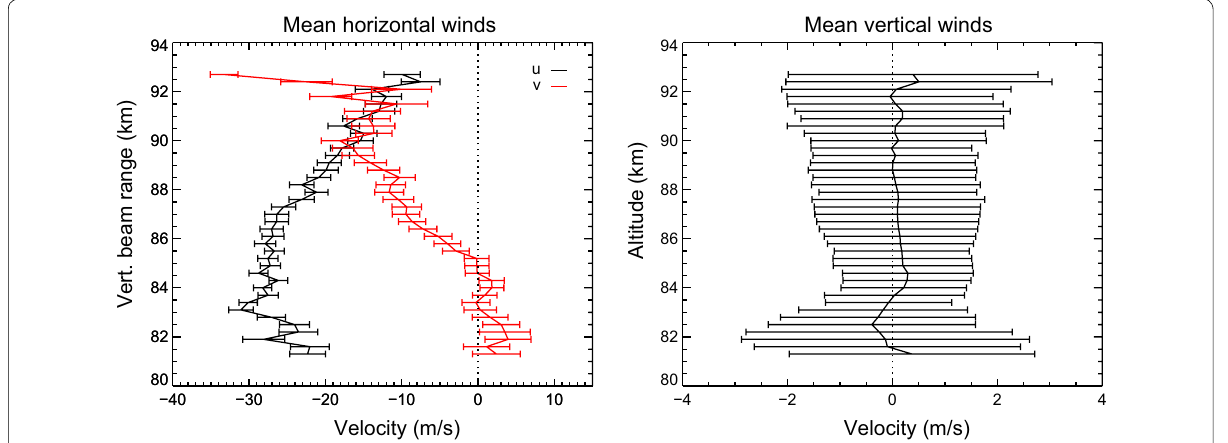
Fig. 7 Mean wind components for the entire observational period. Error bars indicate the one sigma standard